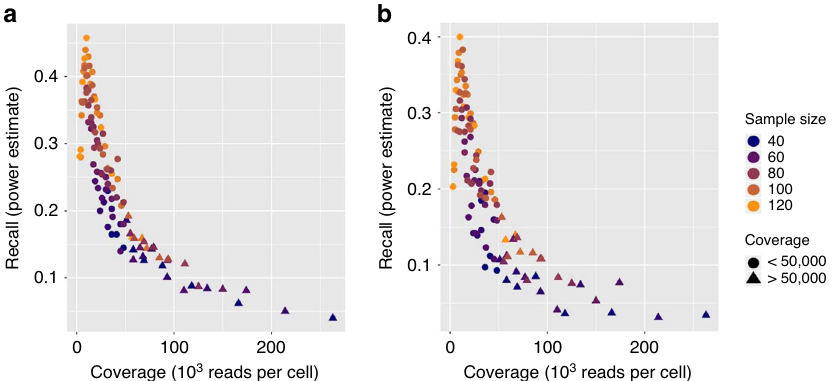
Fig. 6 Performance of ct-eQTL analysis. Shown here is recall (power estimate) as a function of coverage in the ct-eQTL analysis of CD4 T cells at fi xed budget $35,000. a Mean ct-eQTL; b